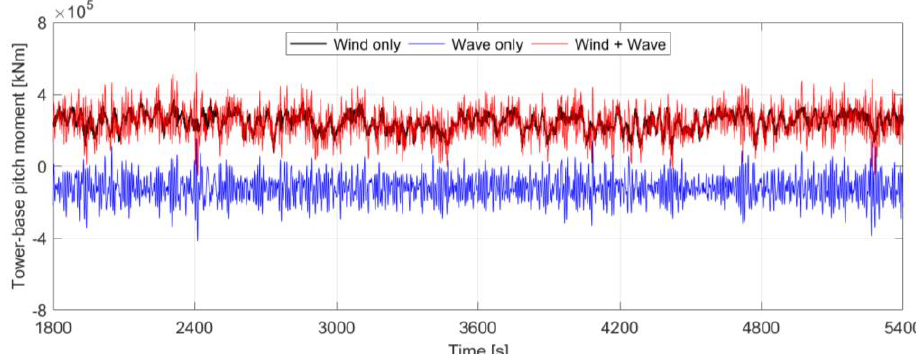
Figure 6. Time series of tower-base pitch moments for three specified conditions.